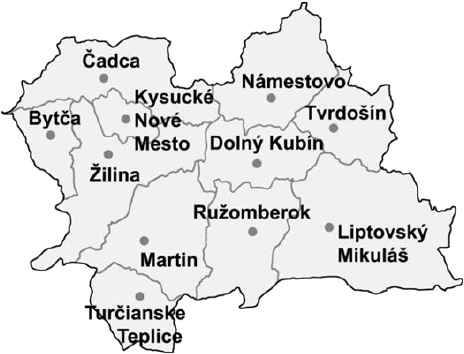
Figure 4. Districts of the autonomous region of Žilina.